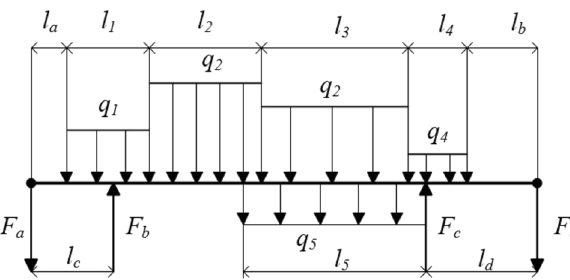
Figure 4. Simplified mechanical model of